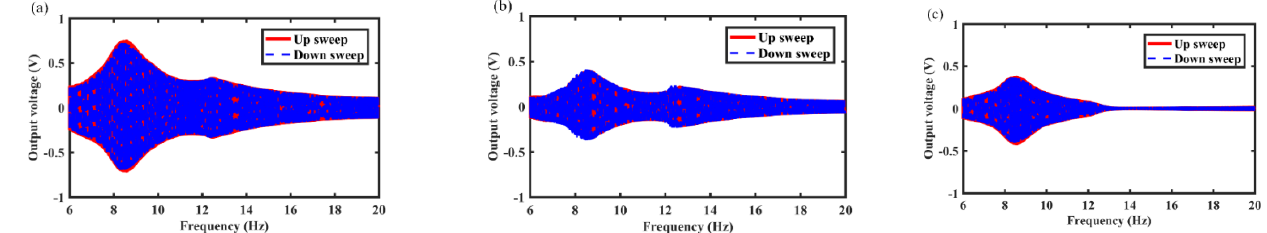
Figure 5. Frequency sweep response of the MCEEH with excitation acceleration of 0.3 g: ( a ) coil 1; ( b ) coil 2; ( c ) coil 3.